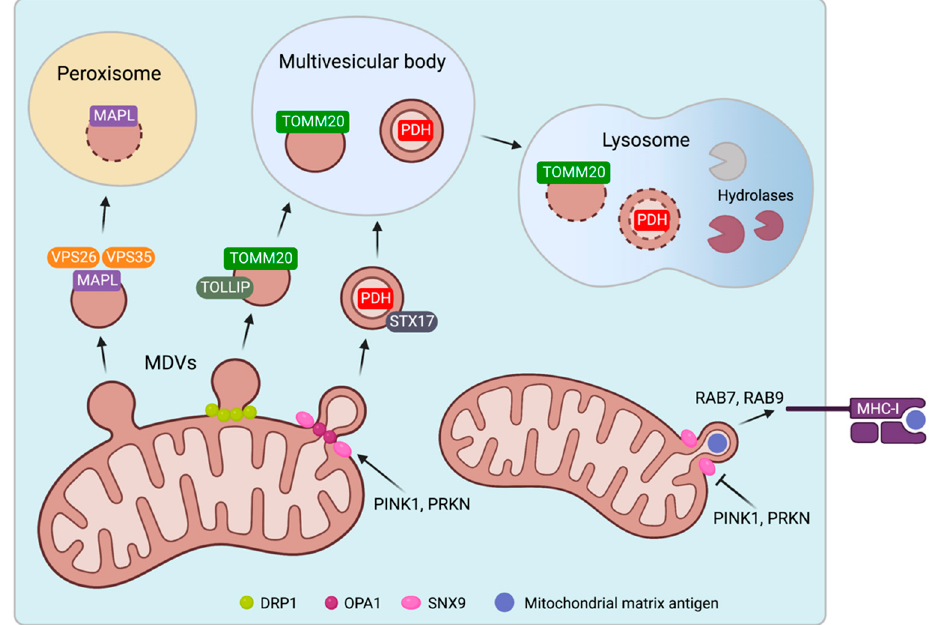
Figure 2. Biogenesis and trafficking of mitochondrial-derived vesicles (MDVs). The formation of specific MDV populations, which are then directed to their cellular destination, is governed by dis- tinct mechanisms. MAPL + MDVs are recruited to peroxisomes by VPS26 and VPS35. TOMM20 + /PDH − and TOMM20 − /PDH + MDVs are shuttled to the endolysosomal system by TOLLIP and STX17. MDVs containing mitochondrial matrix proteins allow for the presentation of mitochon- drial antigen on the cell surface. Created with BioRender.com.